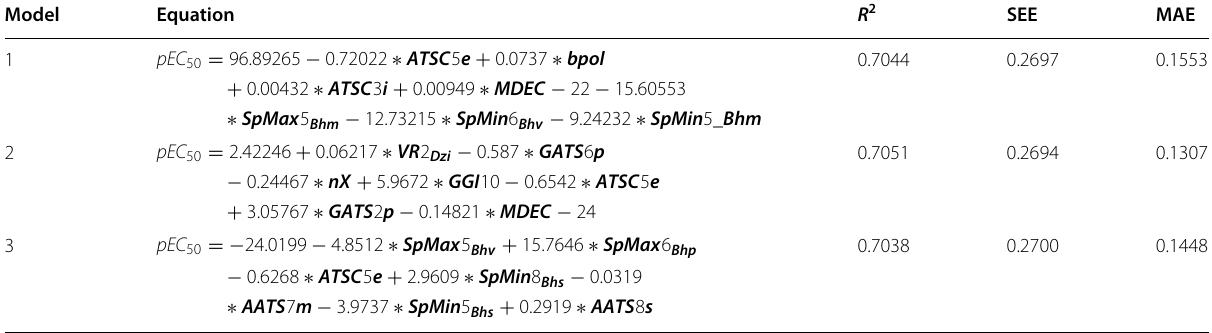
R 2 , coefficient of determination; SEE, standard error of estimate; MAE, mean average error